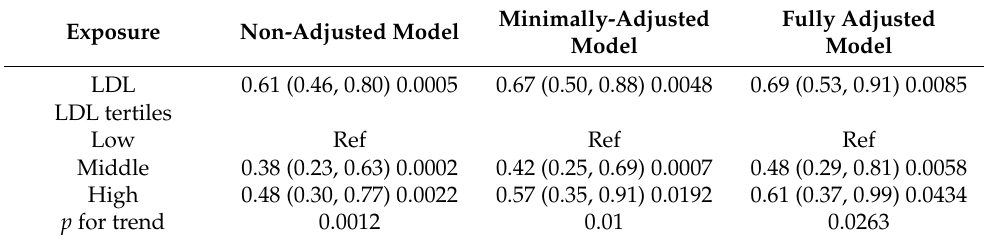
Data in table: HR (95%CI) p -value Outcome variable: mortality Exposed variables: LDL, Minimally adjusted model adjusted for: age; sex. Fully adjusted model adjusted for age, sex, CHD, arrhythmia, dementia, and treatment strategy.